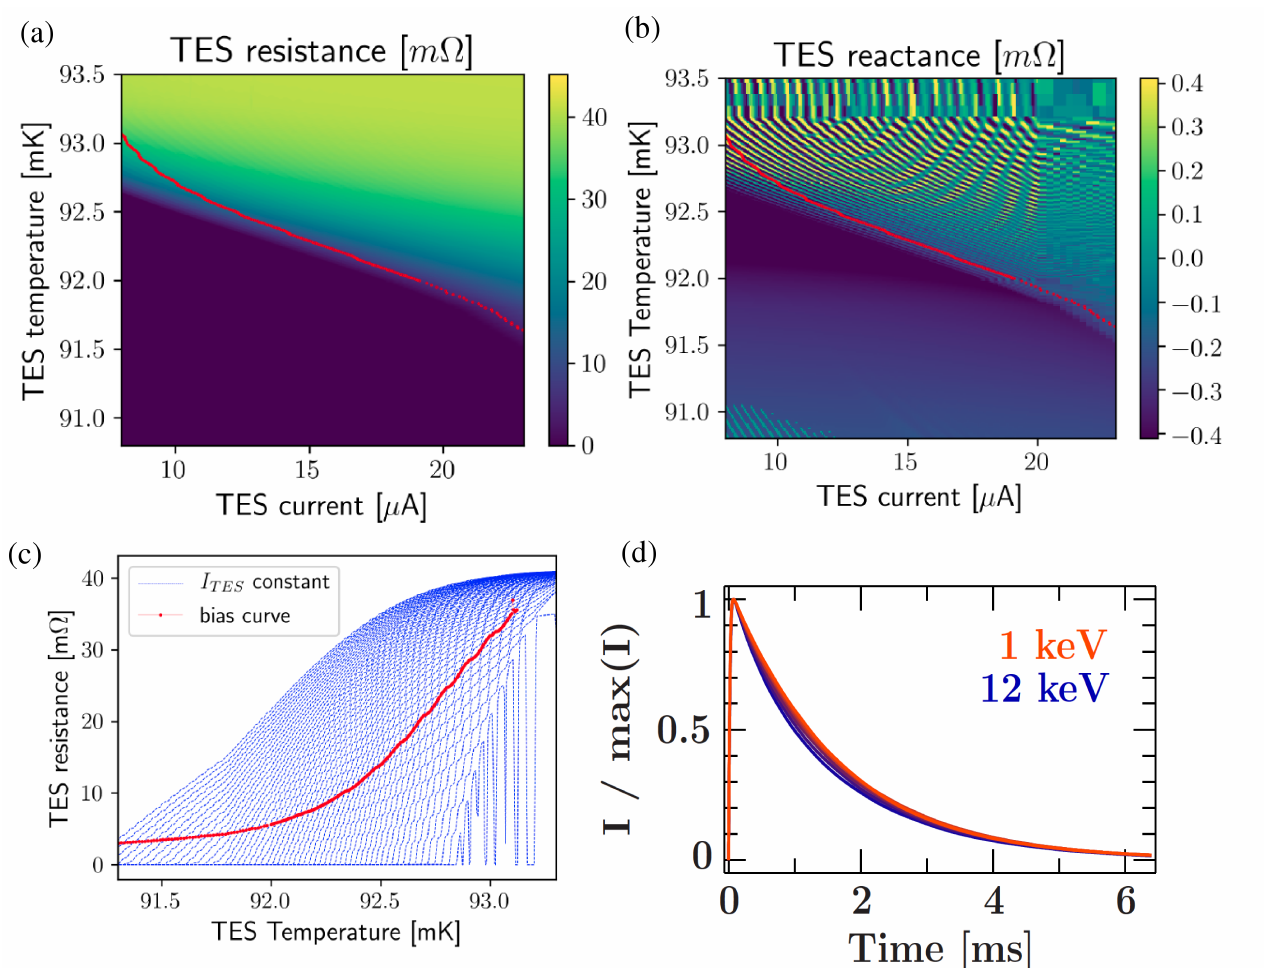
Figure 5. Colormaps of the TES resistance R ( I , T ) ( a ) and reactance X ( I , T ) ( b ) calculated for an NASA-GSFC 100 × 100 µ m 2 TES microcalorimeters biased at f bias = 3.081MHz. ( c ) R ( T ) curves calculated at a constant TES current. ( d ) Simulated X-ray pulses from photons of energy from 1–10 keV, for a TES biased at 1 MHz at R / R n = 10%, credits C. Kirsch,